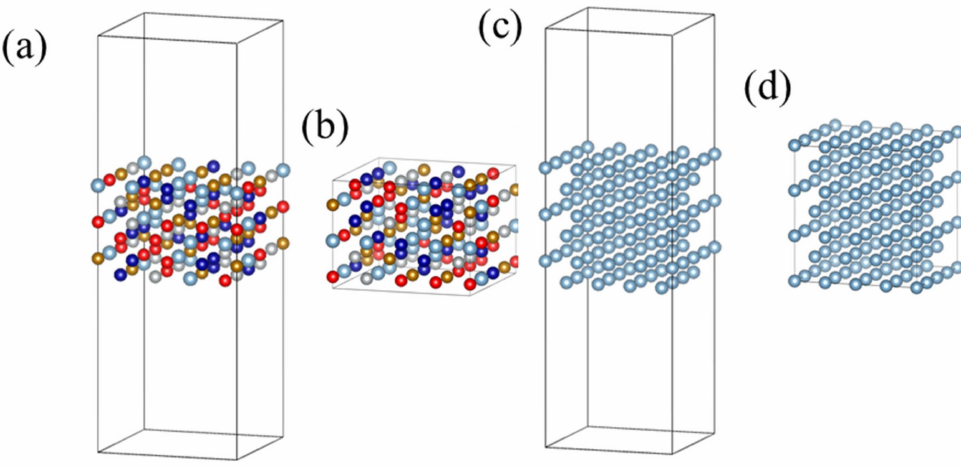
Figure 2. The supercells for model systems of ( a ) AlCoCrFeNi HEA with free surfaces, ( b ) bulk HEA, ( c ) Al with free surfaces, and ( d ) bulk Al, used in the calculation of surface energy and interfacial